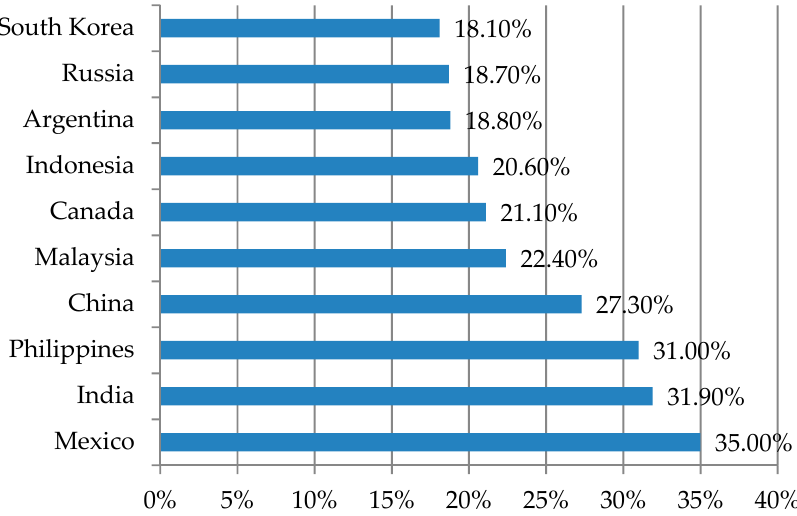
Figure 5. Top 10 countries by e ‐ commerce growth in 2019.